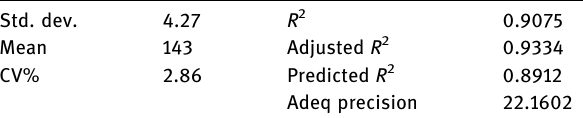
Table 8: Fit statistics for tensile strength Std.